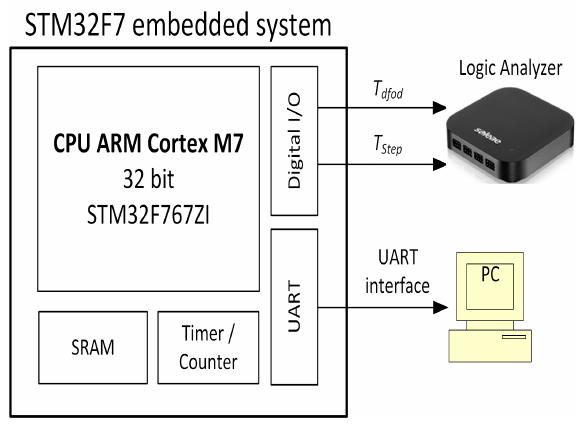
Figure 1. The experimental